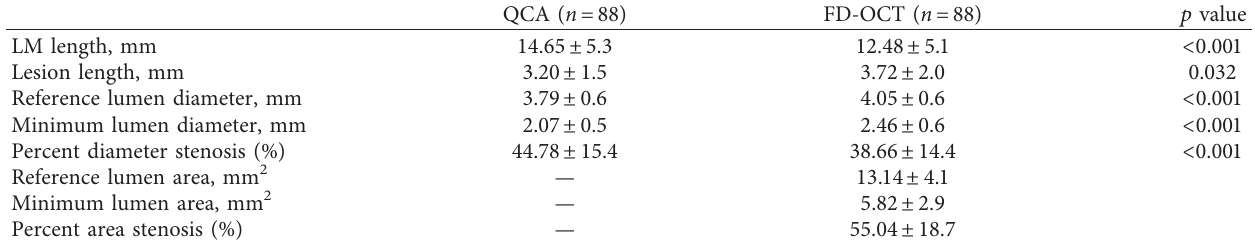
Table 2: Angiographic and optical coherence tomography measurements of the LM lesions.